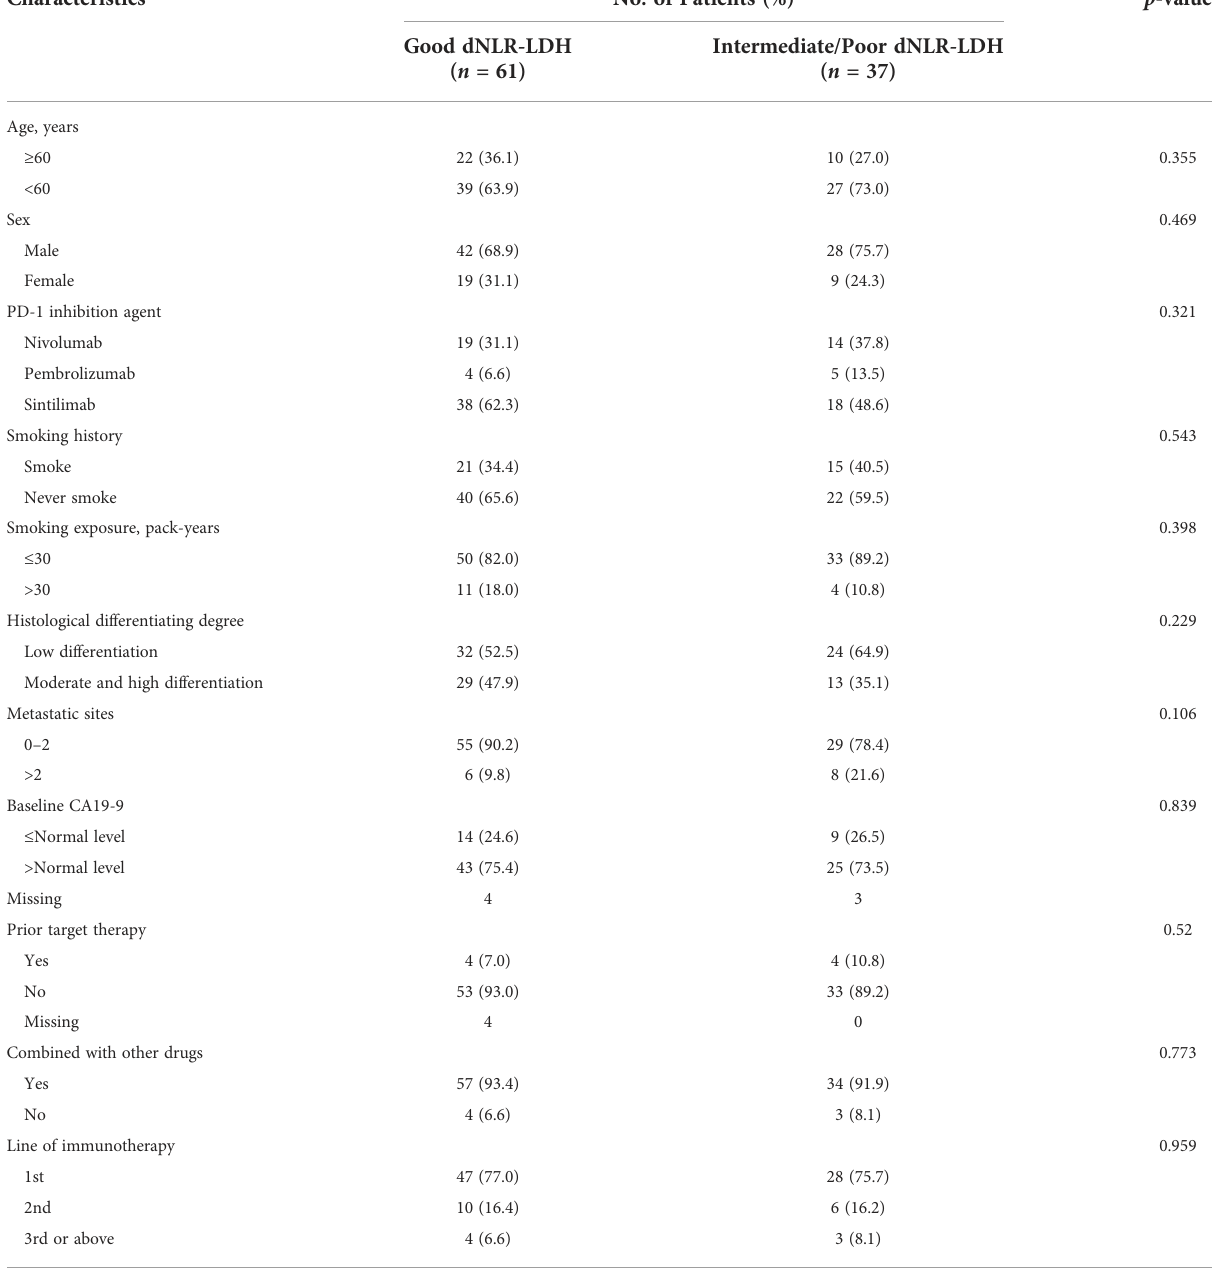
TABLE 2 Differences of patients ’ characteristics between the good dNLR-LDH group and the intermediate/poor dNLR-LDH group.